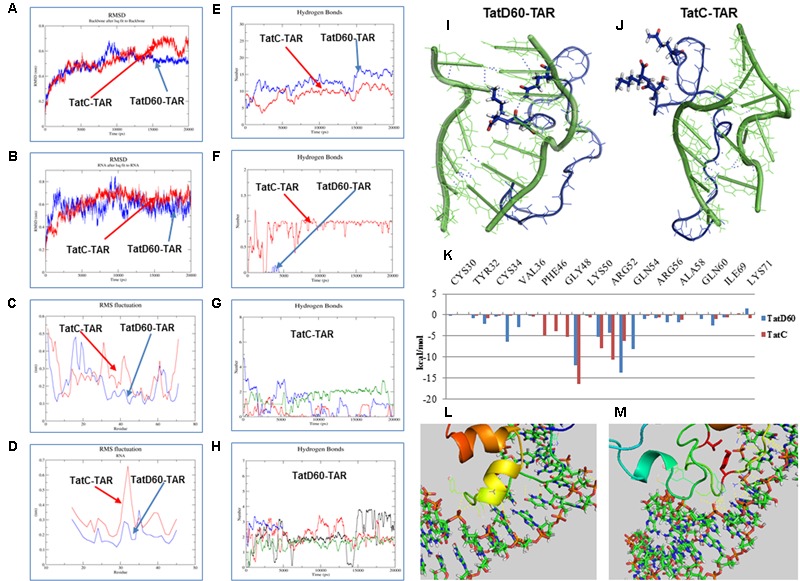
Molecular dynamic (MD) simulation of Tat protein with TAR. MD simulation for Tat–TAR was carried out for 20 ns to predict root mean square deviation (RMSD) of Tat variants. (A) RMSD of Tat residues in wild-type TatC–TAR (Red line) and TatD60–TAR (Blue line). (B) RMSD of TAR ribonucleotides in wild-type TatC–TAR (Red line) and TatD60–TAR (Blue line). (C) Root mean square fluctuation (RMSF) of Tat individual residues in wild-type TatC–TAR (red line) and TatD60–TAR (blue line). (D) RMSF of TAR individual ribonucleotides in wild-type TatC–TAR (red line) and TatD60–TAR (blue line). Hydrogen bonds in Tat–TAR complex. Number of H-bonds formed between Tat variants and TAR per time frame was measured; (E) number of H-bonds in wild-type TatC–TAR complex (red line) and TatD60–TAR complex (blue line). (F) Number of H-bonds formed at Ser46th position in wild-type TatC–TAR complex (red line) and at Phe46 in TatD60–TAR complex (blue line). (G) Number of H-bonds formed by TAR ribonucleotides of A22 (black line), U23 (red line), C24 (green line), and U25 (blue line) in wild-type TatC–TAR complex. (H) Number of H-bonds formed by TAR ribonucleotides of A22 (black line), U23 (red line), C24 (green line) and U25 (blue line) in TatD60–TAR complex. Tat variants interaction with TAR during simulation. Tat protein (blue) and TAR (green) interaction in the bulge region at the end of 20 ns simulation was captured. H-bonds represented in dotted blue lines. (I) Structure of wild-type TatC–TAR complex during 20 ns simulation. (J) Structure of TatD60–TAR complex during 20 ns simulation. Binding free energy of Tat–TAR complex. (K) Relative residue-wise energy contribution for binding wild-type TatC–TAR and TatD60–TAR complexes. Only selected residues with important contribution are shown. Comparison of crystal structure and modeled structure of Tat–TAR complex. Comparison of docked structure of Tat–TAR complex with homology modeled Tat structure and with the crystal structure (PDB ID: 5L1Z) of Tat. (L) Crystal structure complex of TatD60–TAR. (M) Homology modeled structure complex of TatD60–TAR.